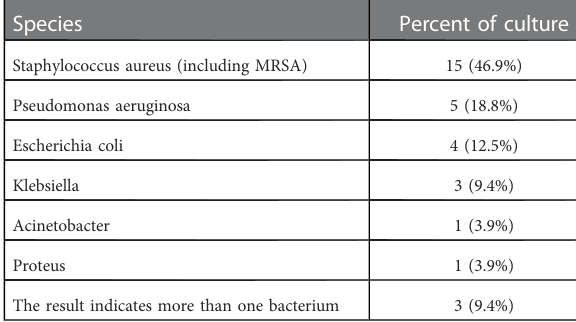
TABLE 1 Proportion of bacterial species growth in culture .